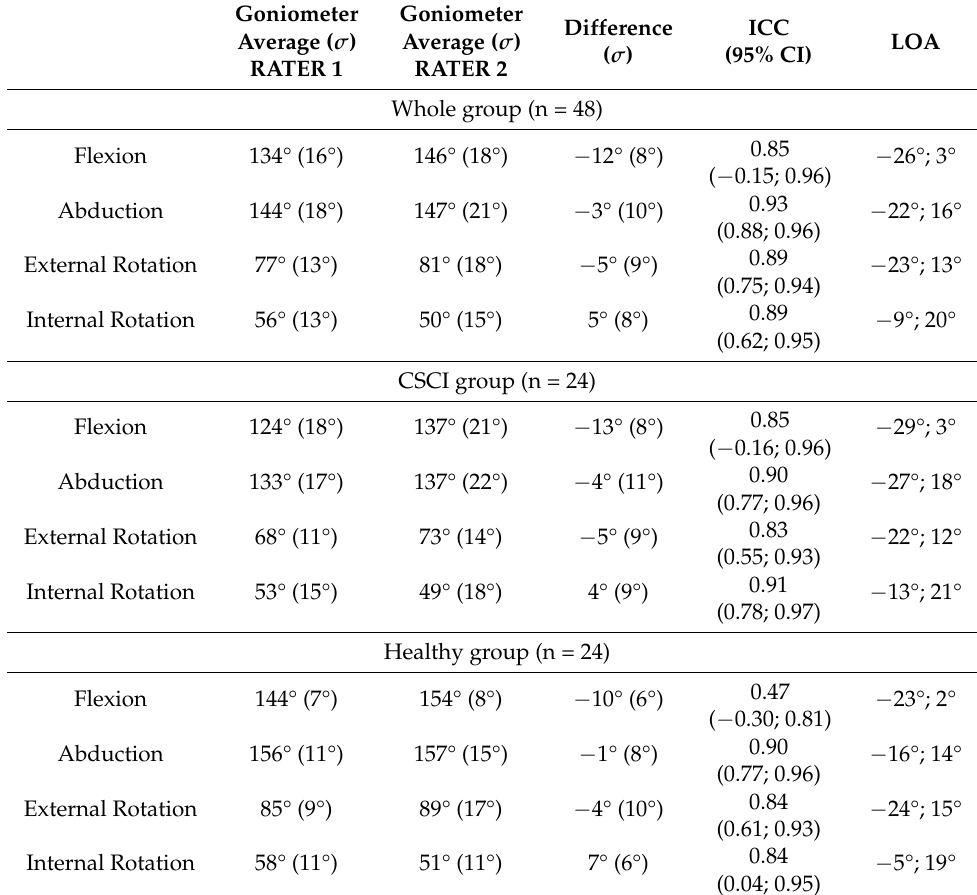
Table 9. Inter-tester/rater reliability indicators for goniometer measurements in CSCI patients and healthy group for RATER 1 and RATER